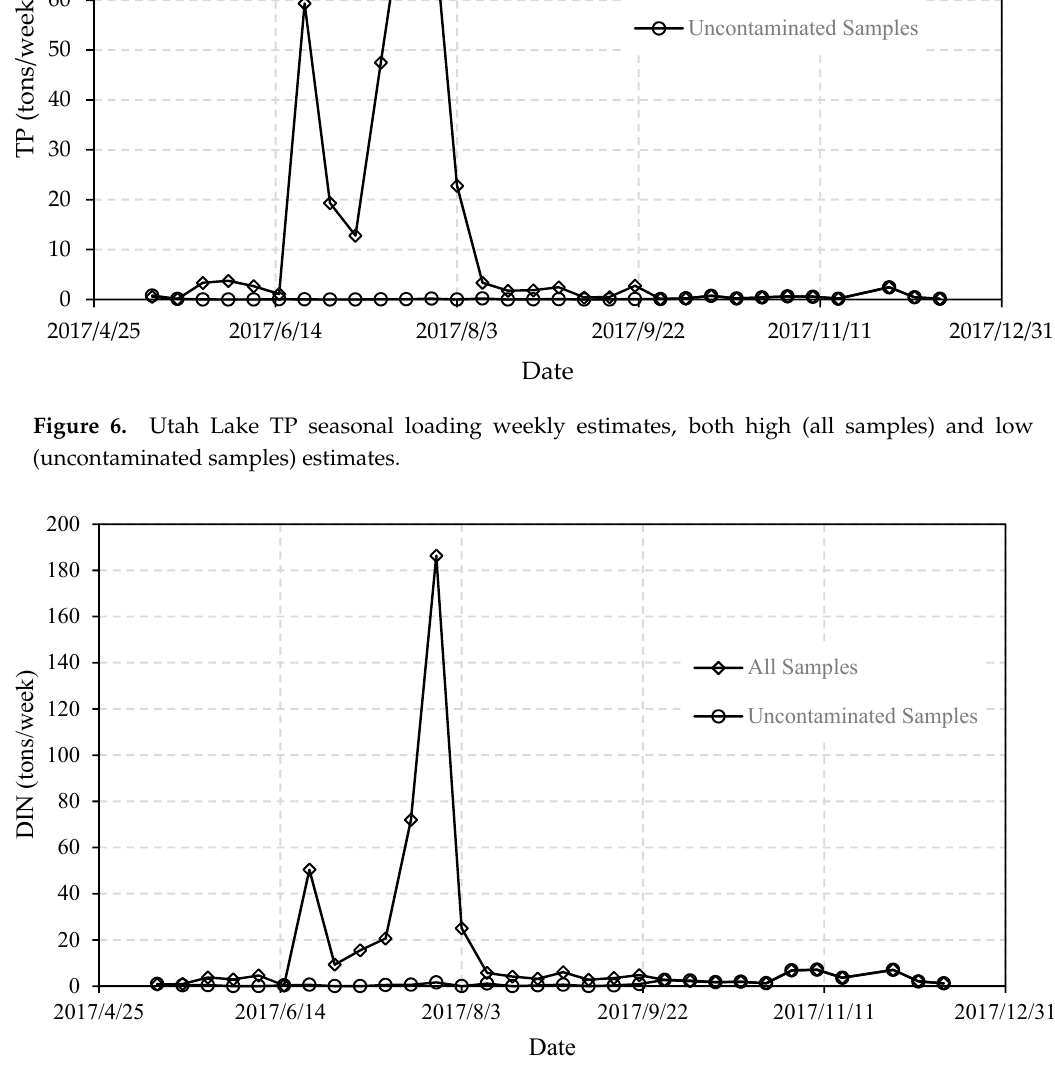
Figure 7. Utah Lake DIN seasonal loading weekly estimates, both high (all samples) and low (uncontaminated samples) estimates.